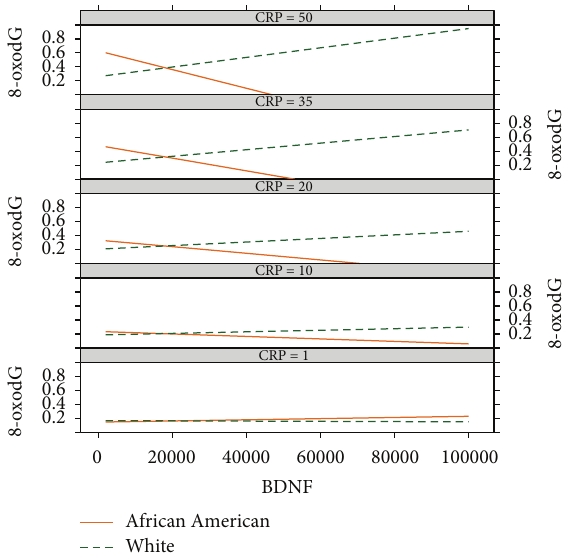
Figure 2: Association of 8-oxodG on BDNF at selected levels of pulse pressure in African Americans (AA) and whites. For the graphs, each box indicates different levels of pulse pressure (PP). BDNF is indicated on the 𝑥 -axis and 8-oxodG is shown on the 𝑦 - axis. At all levels of pulse pressure and at high levels of BDNF, AA women have high levels of 8-oxodG whereas white women have low levels of